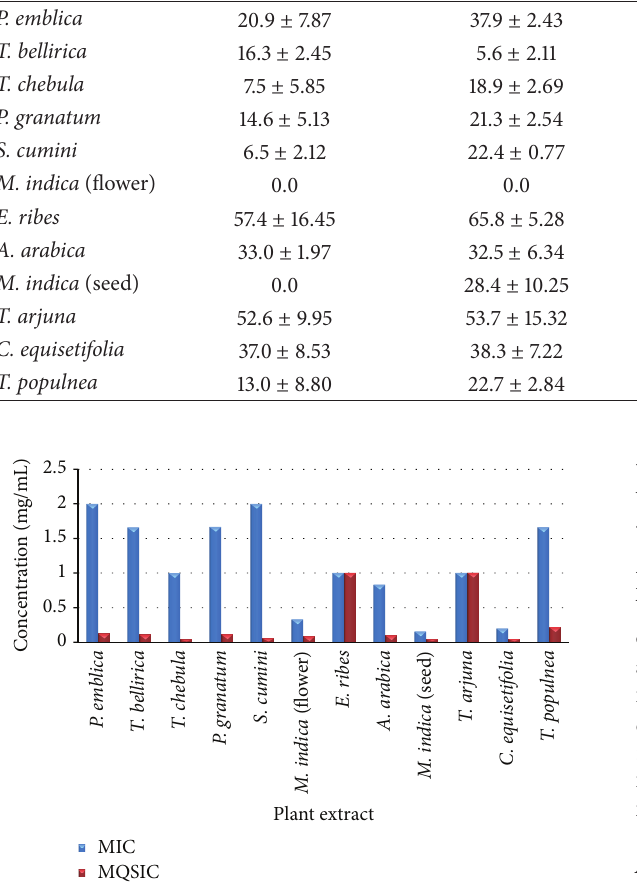
Figure 3: Comparison of MIC values with MQSIC values for anti- quorum sensing activity of plant extracts, detected using biosensor strain S. aureus agr P3:: blaZ